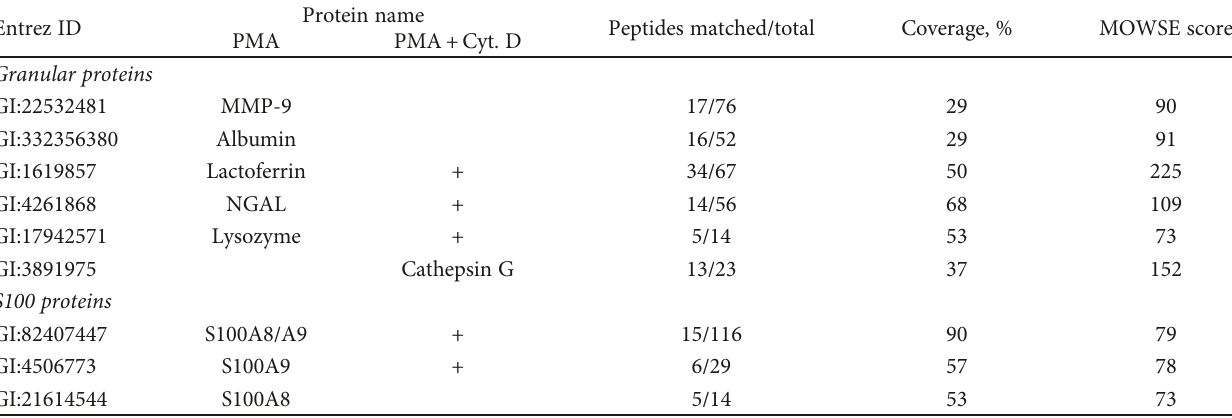
Table 2: A list of proteins that were secreted by neutrophils into the extracellular medium during a 20 min incubation with fi bronectin-coated substrata under control conditions, in the presence of 0,1 μ M PMA alone or in the presence of both 0,1 μ M PMA and 10 μ M cytochalasin D (PMA +Cyt. D). Mass spectrometric analysis data were taken from experiments with PMA. Analogous proteins that were identi fi ed in experiments with PMA+Cyt. D are marked (+). Proteins were separated by SDS-PAGE and identi fi ed by mass spectrometric analysis. Proteins identi fi ed in two or three analogous experiments were included in the list.